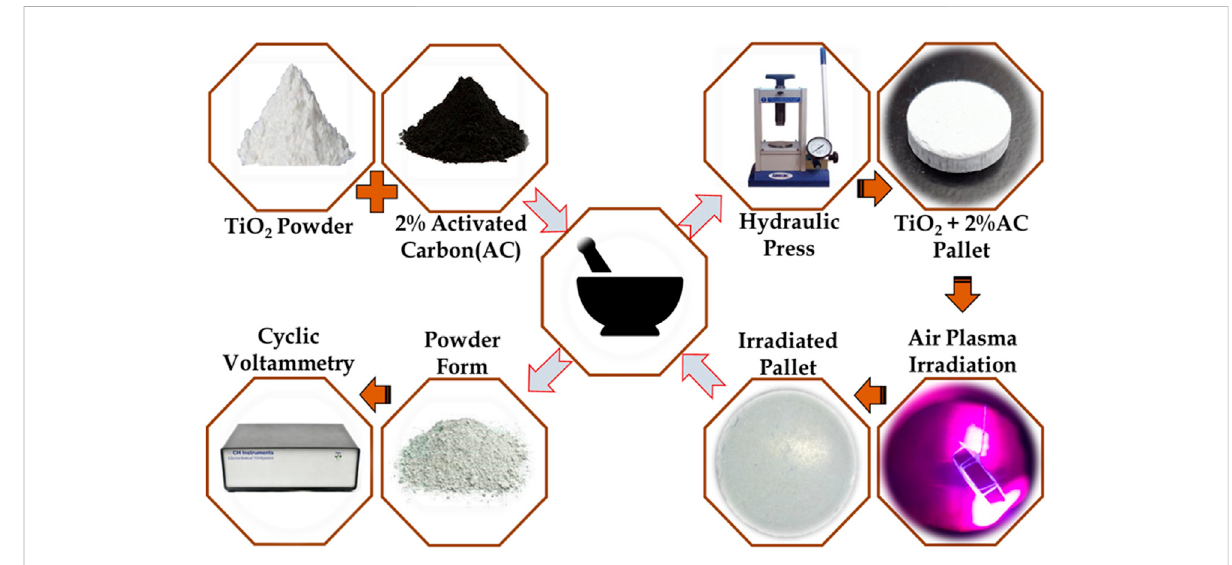
FIGURE 2 SynthesismethodologiesfollowedforcompositeTiO2@ACformation(inleftabovepart),pelletpreparationprocedureforplasmairradiation(in right part), and left below for electrochemical